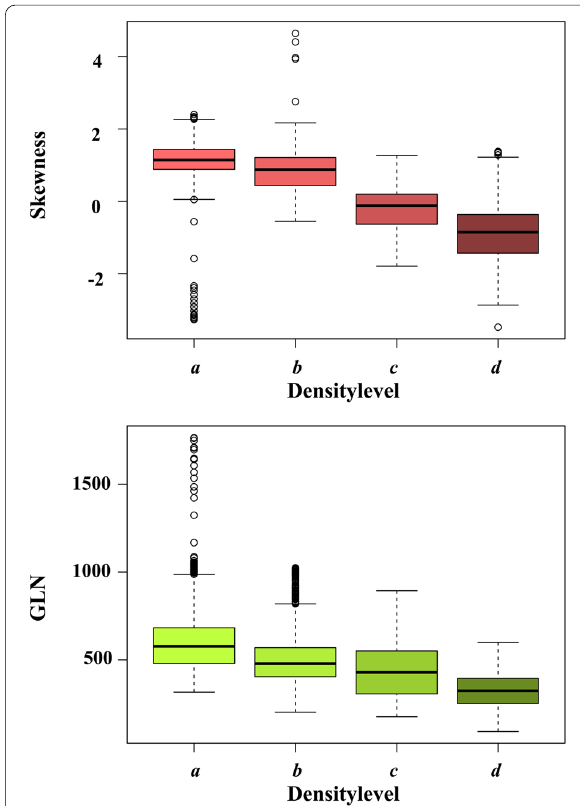
Fig. 5 Boxplots of mean values of the two independent texture features derived from texture analysis: skewness and grey-level nonuniformity (GLN)